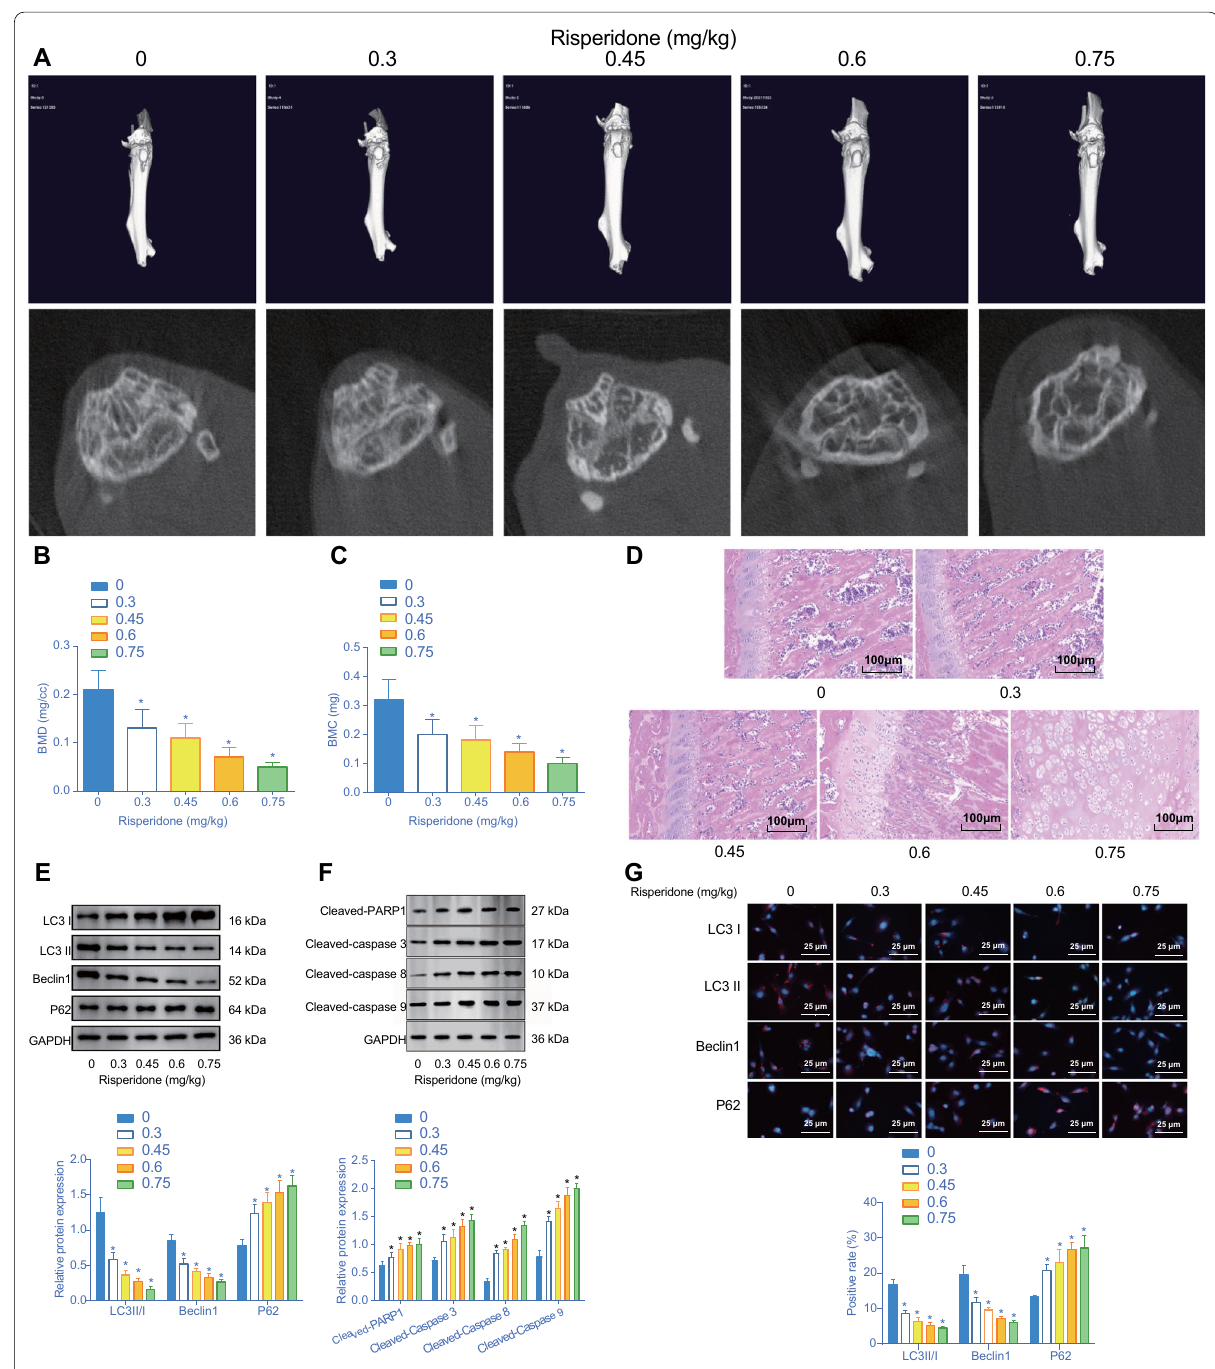
Fig. 2 Risperidone causes an inhibition of autophagy and a promotion of apoptosis in femur tissues of mice. Mice were treated with 0, 0.3, 0.45, 0.6, 0.75 mg/kg of Risperidone. A representative micro-CT 3D and plan scan images of cross-sectional area of femur tissues. B statistical analysis of BMD in femur tissues of mice assessed by micro-CT. C statistical analysis of BMC in femur tissues of mice. D representative images of HE staining in femur tissues of mice. E Western blot analysis of autophagy-related proteins (LC3 II/I, Beclin1, and p62) expression in femur tissues of mice. The band intensity was assessed. F Western blot analysis of apoptosis-related proteins (cleaved PARP1, cleaved caspase-3, cleaved caspase-8 and cleaved caspase-9). Different numbers represent different concentrations of Risperidone (mg/kg). G co-localization of LC3 II (red), LC3 I (red), Beclin1 (red), and p62 (red) with the osteoblast marker RUNX2 (green) by double-labeled immunofluorescence, wherein the nucleus is labeled by DAPI (blue). * p < 0.05, compared with the treatment of 0 mg/kg of Risperidone. The experiments are repeated 3